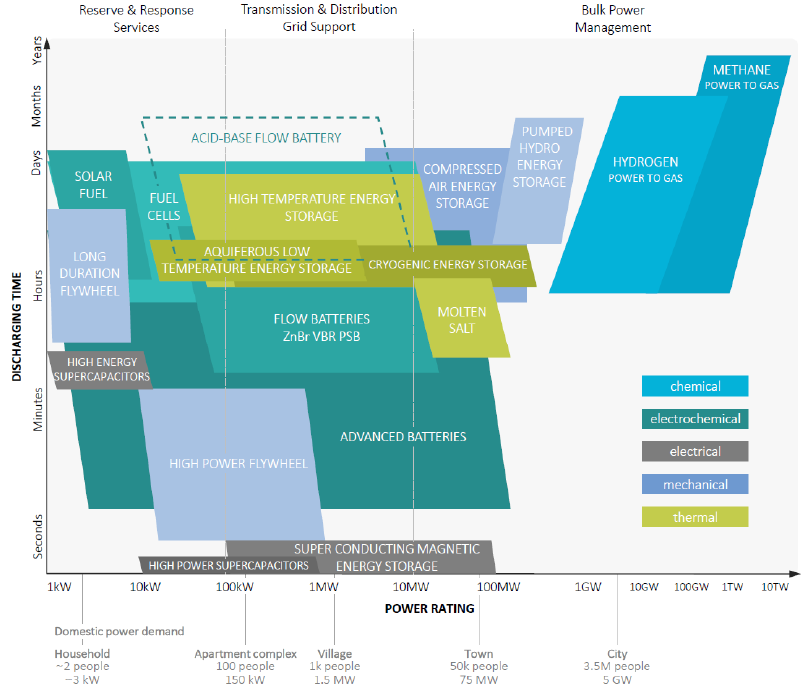
Figure 1. Energy storage systems and their conceptual comparison in terms of discharging time and power range. The figure is simplified, to give a qualitative comparison, and is not intended to be exhaustive; many of the storage systems can have broader operational ranges than shown. The domestic power demand scale is based on peak electric load demand of 3 kW per average EU household (~2 people). Adapted from Reference